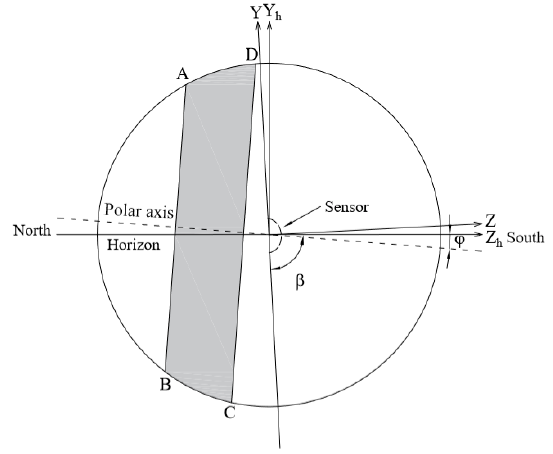
Figure 14. Schematic diagram for the calculation of S h while d r ≤ 0 and φ h , r , min > π − β